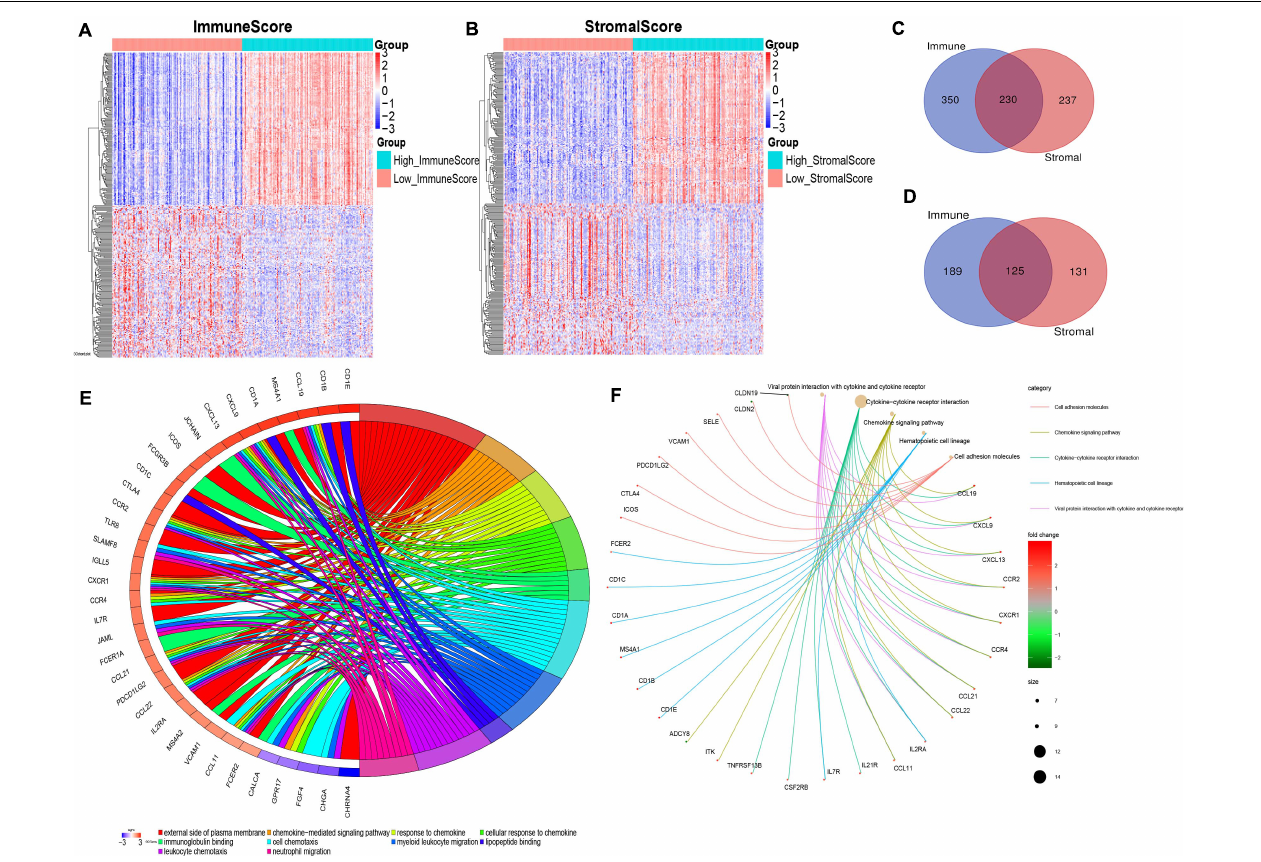
FIGURE 2 | Identification and functional enrichment of differentially expressed genes. (A) Heatmap for DEGs generated by comparison of the high ImmuneScore group with the low ImmuneScore group. Rows and columns represent DEGs and samples, respectively. Significant DEGs were determined with FDR < 0.05 and | fold-change| > 1.5 after log2 transformation. (B) Heatmap for DEGs in StromalScore, similar with (A) . (C,D) Venn plots showing common upregulated and downregulated DEGs shared by ImmuneScore and StromalScore. (E) GOChord plot of GO enrichment analysis for common DEGs showing enriched GO terms and corresponding genes. The significance level was set to be with both FDR and q < 0.05. (F) Cnetplot of KEGG enrichment analysis for common DEGs showing enriched KEGG terms and corresponding genes. The significance level was set to be with both FDR and q <